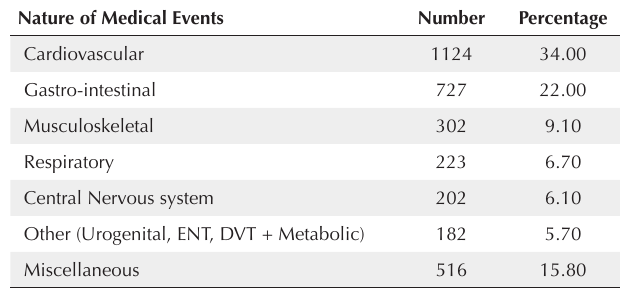
Table 1. Number of Medical Events, Passengers, and Flights Between 2009 and 2011